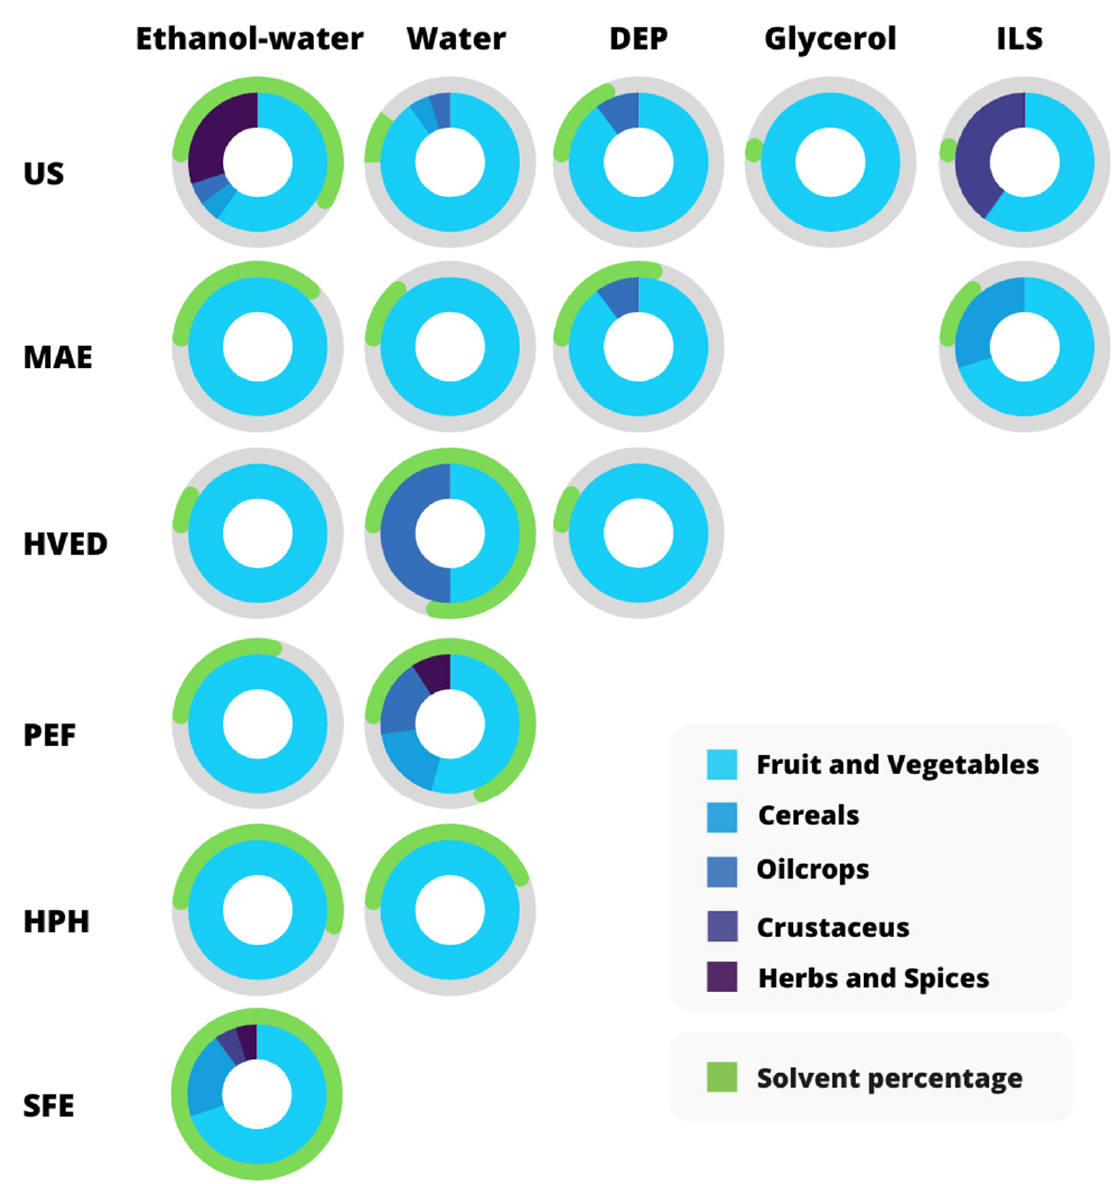
Figure 10. Classification of the green extraction technologies as a function of the solvent used and the food residues source.